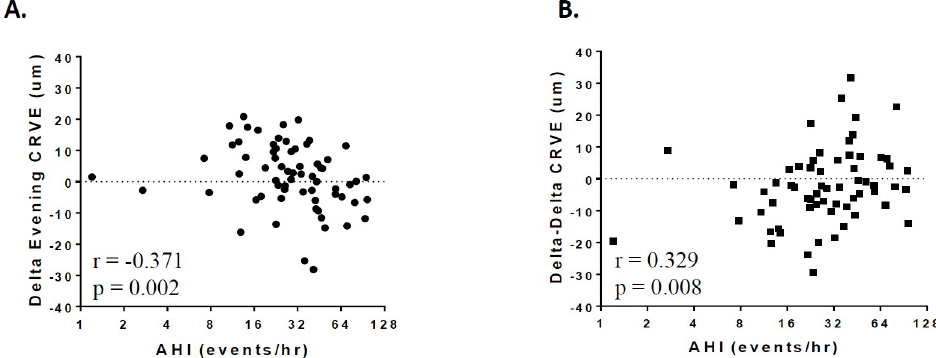
Fig 2. CRVE change with 12 months of RFM/CPAP treatment. Semi-log scatterplots showing change in evening CRVE (A) and change in the overnight difference (morning–evening) for CRVE (Delta-Delta CRVE) (B) plotted against starting AHI across 12 months of RFM/CPAP treatment. Each point represents an individual subject’s data. Delta Evening CRVE represents the change in evening CRVE over the 12 months (12 months − baseline); Delta-Delta CRVE represents the overnight change in CRVE over the 12 months ([morning–evening] 12 months − [morning– evening] baseline ) . r = Spearman’s Correlation